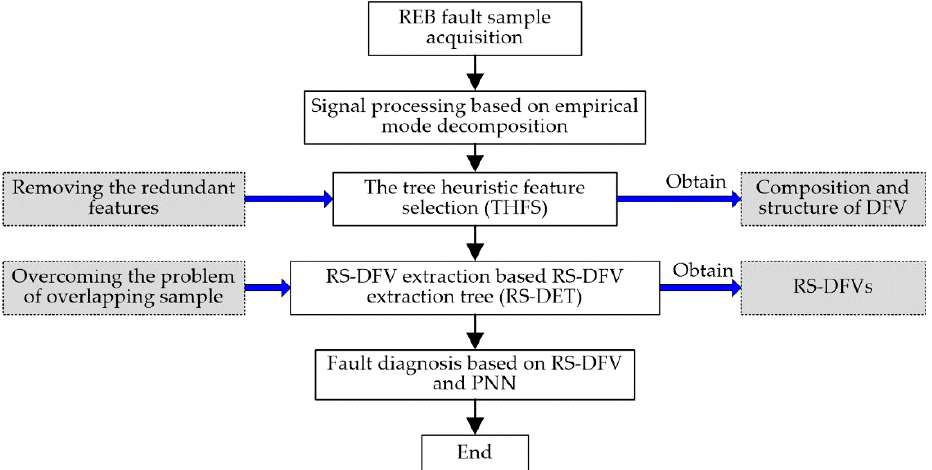
Figure 1. The framework of REB Fault diagnosis based on tree heuristic feature selection (THFS) and the dependent feature vector combined with rough sets (RS-DFV).